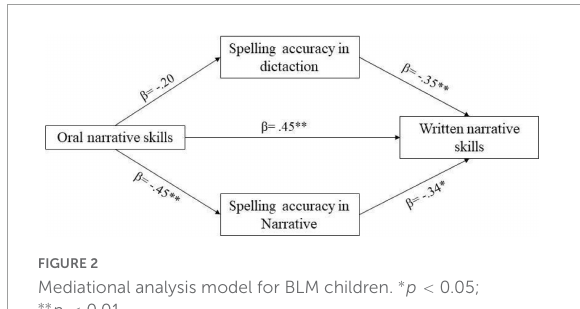
FIGURE2 Mediational analysis model for BLM children. ∗ p < 0.05; ∗∗ p <